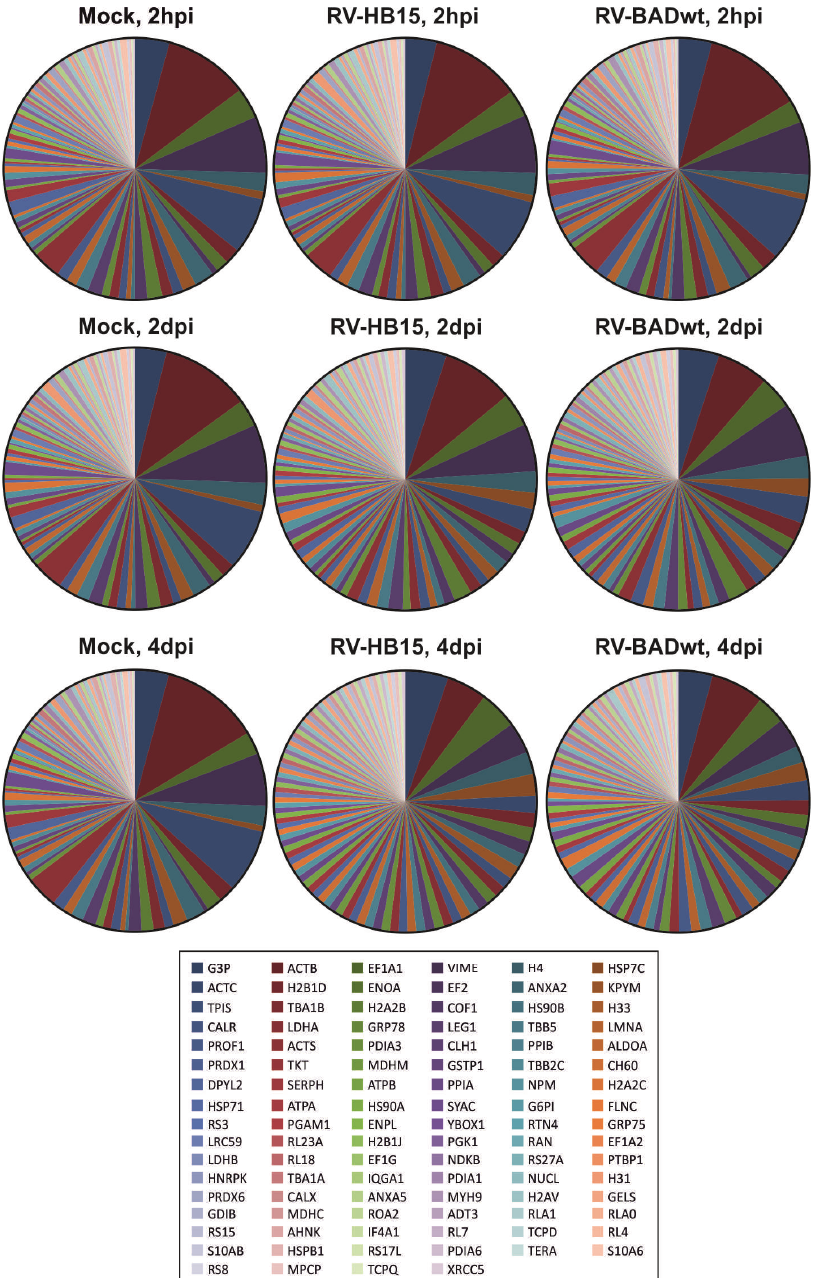
Figure 3. Proteomic analysis of cellular proteins in infected HFF. Fibroblasts were infected with RV-HB15 or RV-BADwt. After 2 hpi, 2 dpi or 4 dpi, the cells were collected and analyzed using nanoUPLC mass spectrometry. The relative frequency of the viral proteins in the samples is shown in the pie charts. Proteins were sorted according to frequencies found in four day RV-HB15 infected fibroblasts, displayed from left to right in the caption. The 100 most frequent proteins in RV-HB15 infected HFF are shown. A detailed representation of the data is provided in the Supplementary Table